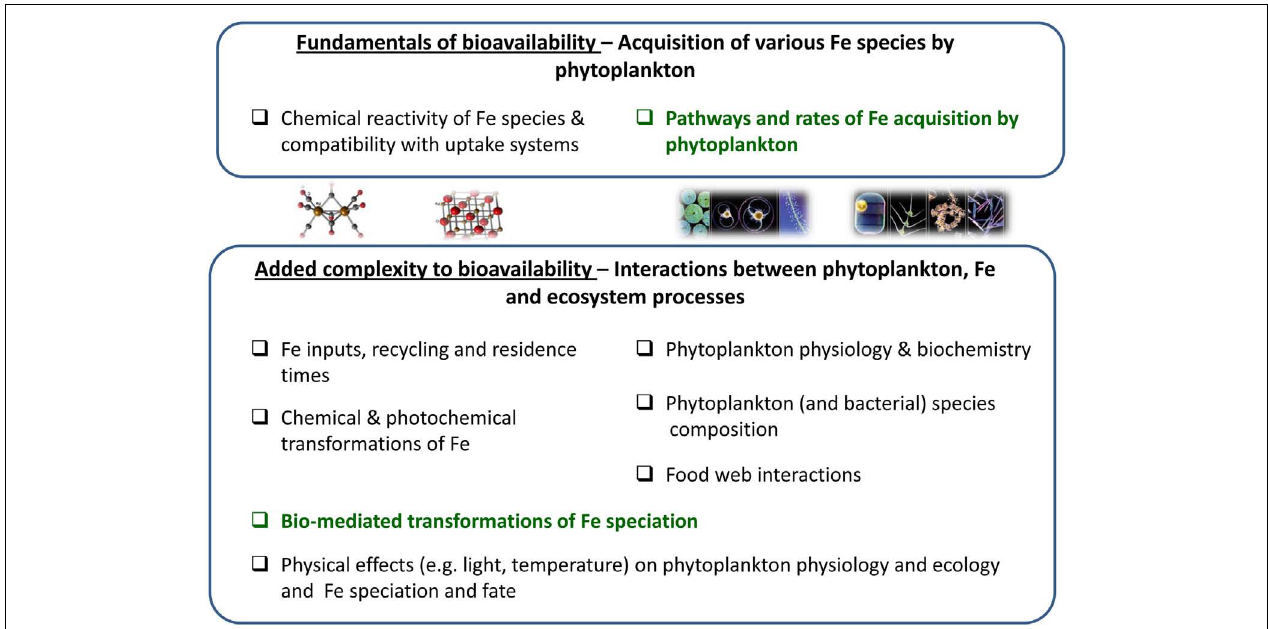
Systems” and “Fundamentals of Fe Bioavailability: Phytoplankton Fe Acquisition Rates” we discuss the experimental evaluation of Fe uptake rates by laboratory cultures and natural populations. In the environment, many other chemical, biological, and physical factors are important for determining Fe availability to phytoplankton, some of which are detailed in the lower box. In Section “Added Complexity to Bioavailability: Bio-MediatedTransformations of Fe Speciation” we turn to organism–Fe interactions and discuss how secretion of organic compounds and bio-mediated redox processes alter Fe speciation and influence Fe